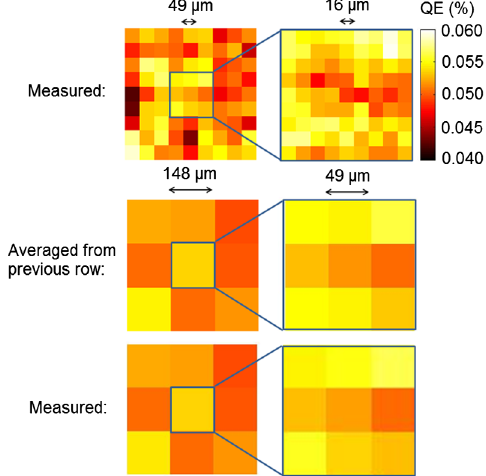
FIG. 3. QE maps. Maps in the right column are magnified by 3:1 compared to their corresponding areas in the left column. The second row shows average maps of the first row, which can be compared to the measured maps of the third row. The first row uses 49 (cid:1) m step sizes on the left and 16 (cid:1) m step sizes on the right. The second and third rows use 148 (cid:1) m step sizes on the left and 49 (cid:1) m step sizes on the right.